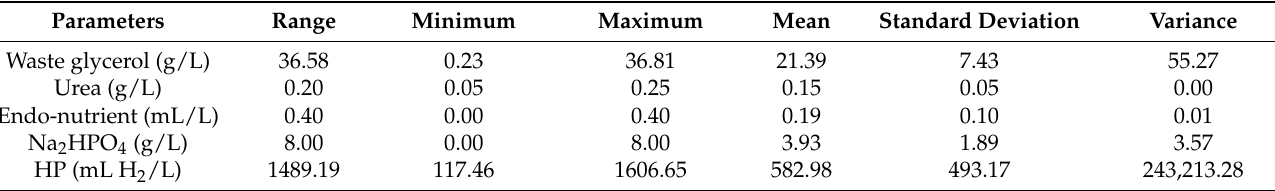
Table 2. Descriptive statistics for input and targeted variables.